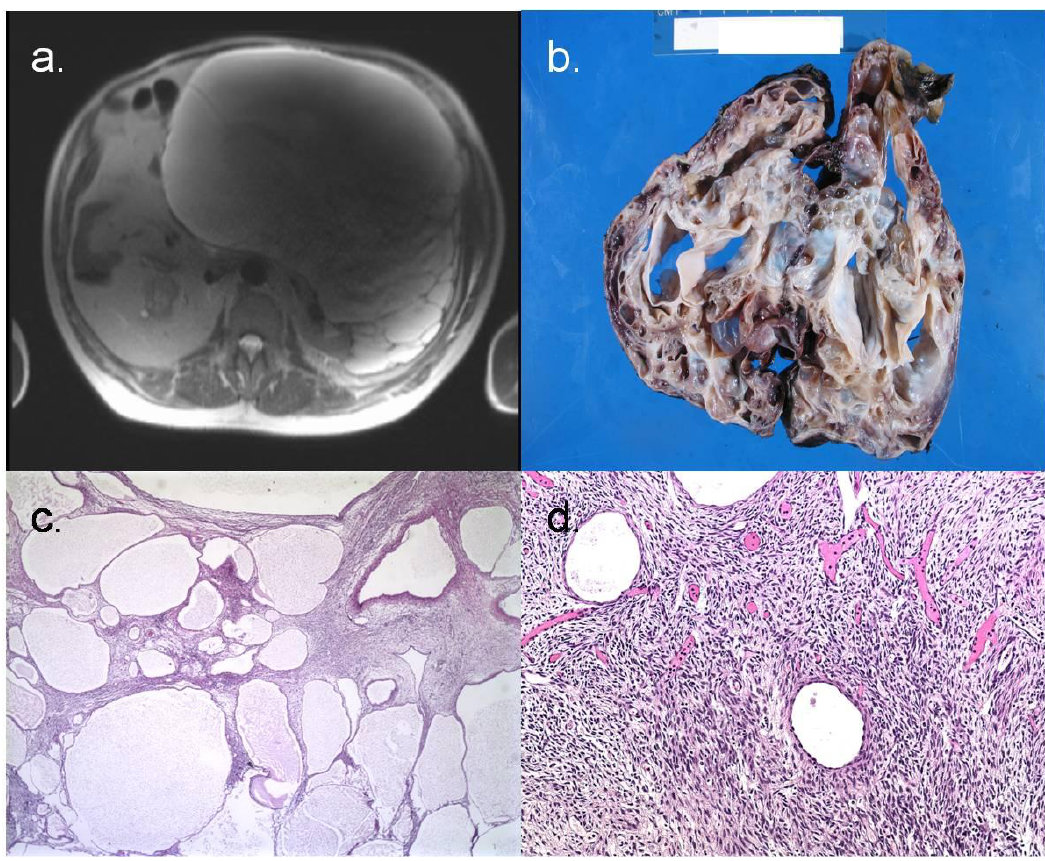
FIGURE 1 . (a) MRI of left abdominal mass, (b) gross pathology specimen, (c) 2  microscopic section demonstrating multiloculated cysts with intervening stroma, (d) 10  microscopic section demonstrating variable cellularity, prominent vessels, and ovarian-type